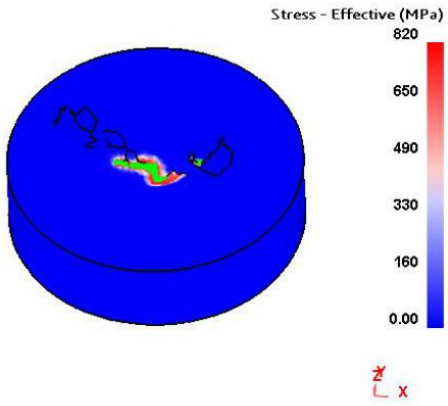
Figure 13. Effective stress distribution.